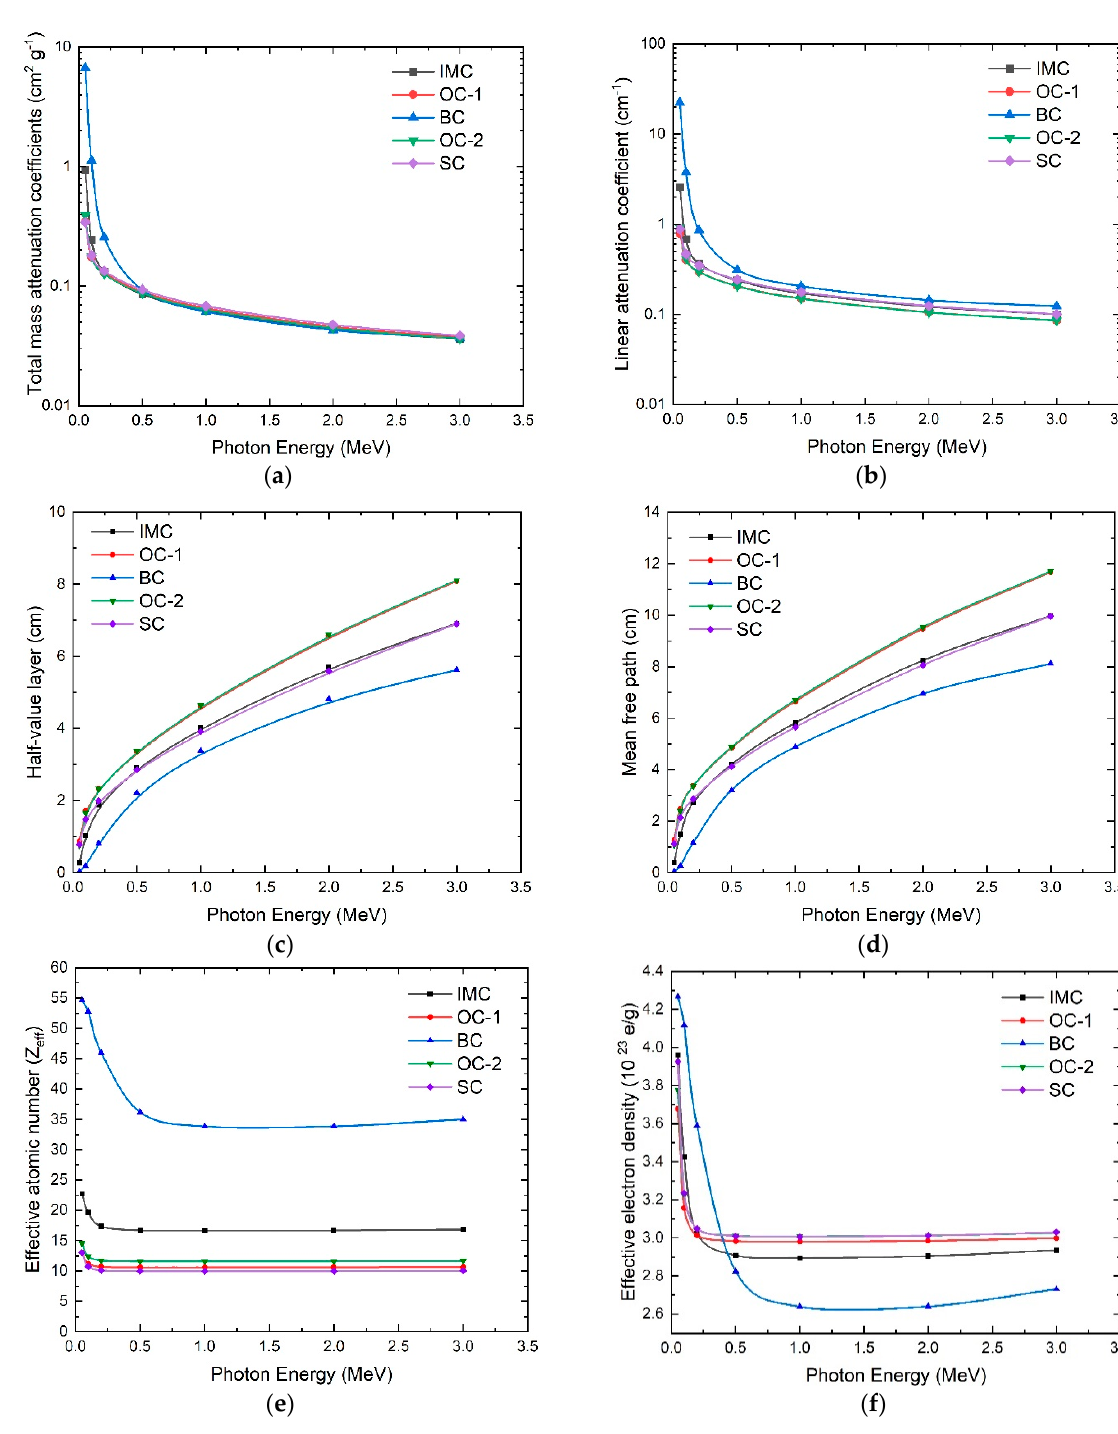
Figure 5. The total mass attenuation coefficients ( a ), linear attenuation coefficients ( b ), half-value layers ( c ), mean free paths ( d ), the effective atomic numbers ( e ), and effect electron densities ( f ) for X-rays with different energies from 0.05 up to 3 MeV for the investigated concrete